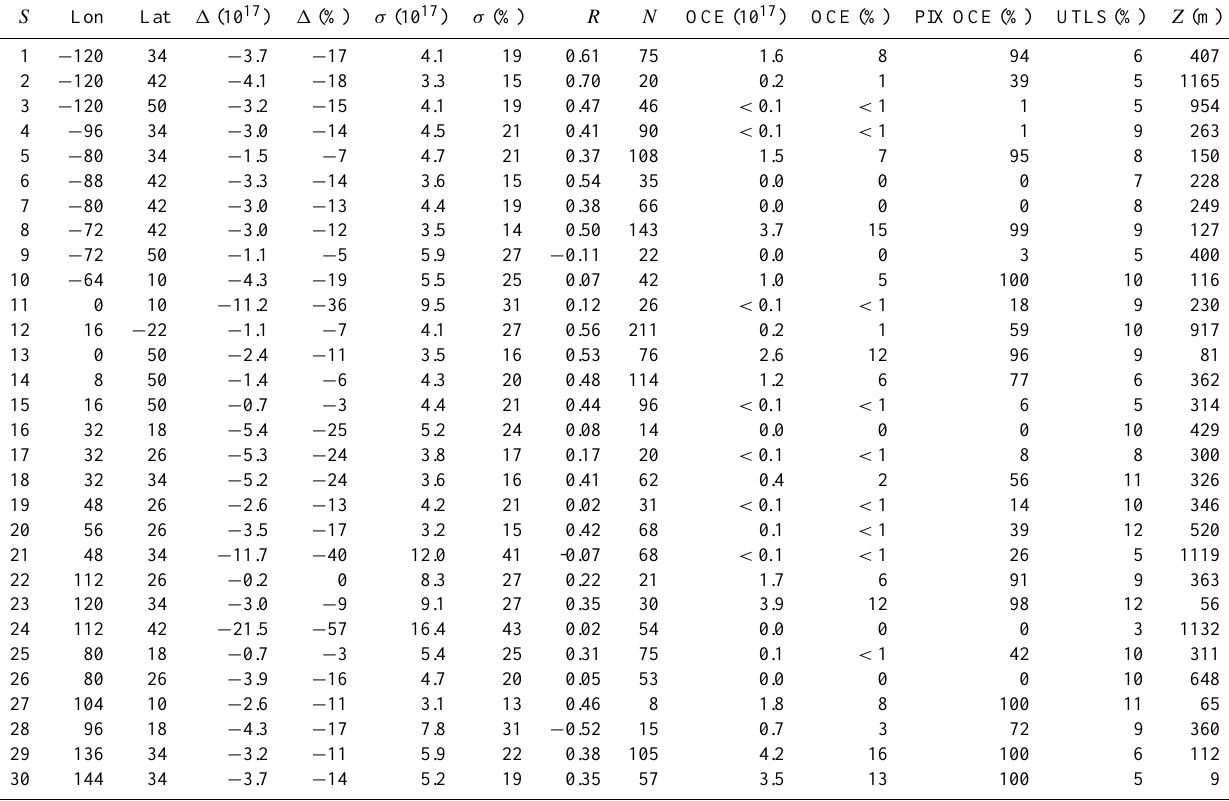
Table 1. 1 is the mean difference between SCIAMACHY and MOZAIC CO total columns (10 17 moleculescm − 2 and percentage). σ is the mean root-mean-square difference between SCIAMACHY and MOZAIC CO total columns (10 17 moleculescm − 2 and percentage). R is the Pearson’s correlation coefficient for the comparison between SCIAMACHY and MOZAIC CO total columns. N is the total number of SCIAMACHY-MOZAIC comparison values. OCE is the estimated below cloud partial CO column for SCIAMACHY CO total column measurements over low altitude clouds over oceans (10 17 moleculescm − 2 and percentage). Note that for many grids, SCIAMACHY averages are based on both land and ocean measurements (see also PIX OCE). PIX OCE is the fractional part of SCIAMACHY measurements taken over low altitude ocean clouds for that particular grid box. UTLS is the TM5 estimated CO column above the maximum height of the MOZAIC profile (percentage of the MOZAIC total column). Z =mean elevation with 8 ◦ × 8 ◦ comparison grid (meters). The first column ( S ) refers to the areas and cities in Fig. 2 and Table 2,